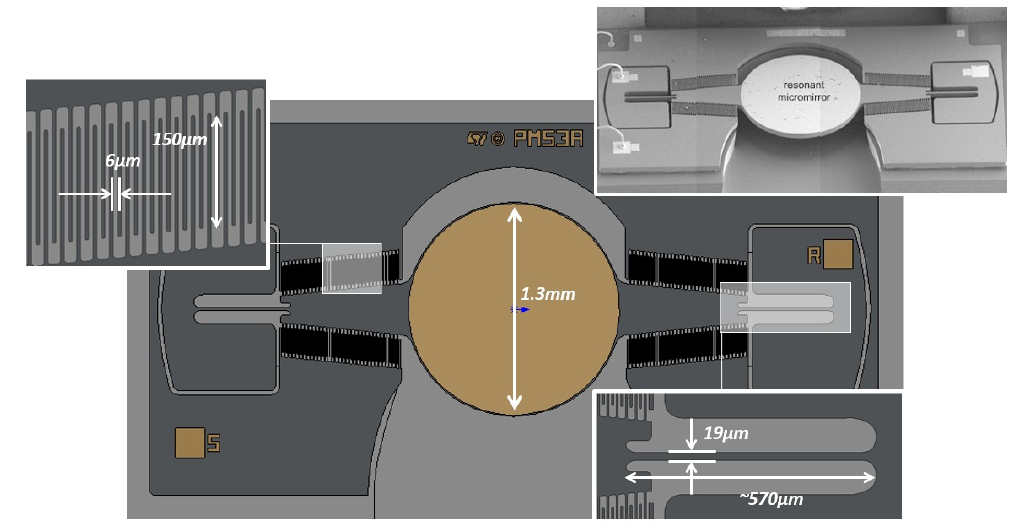
Figure 1. Resonant micro-mirror: SEM image of the device and layout. Courtesy of